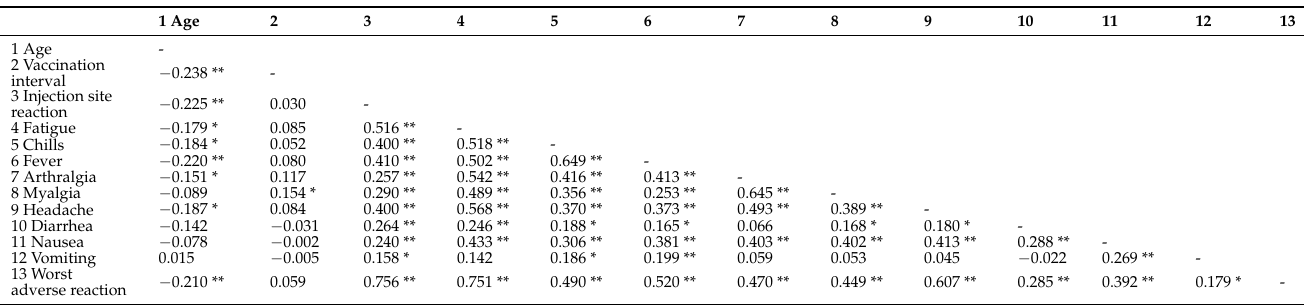
Spearman’s rank correlation was performed. The values indicate the correlation coefficient between age, vaccina- tion interval, and severity of each adverse reaction. *, p < 0.05; **, p < 0.01. The most severe grade of all classified adverse reactions was defined as the worst adverse reaction